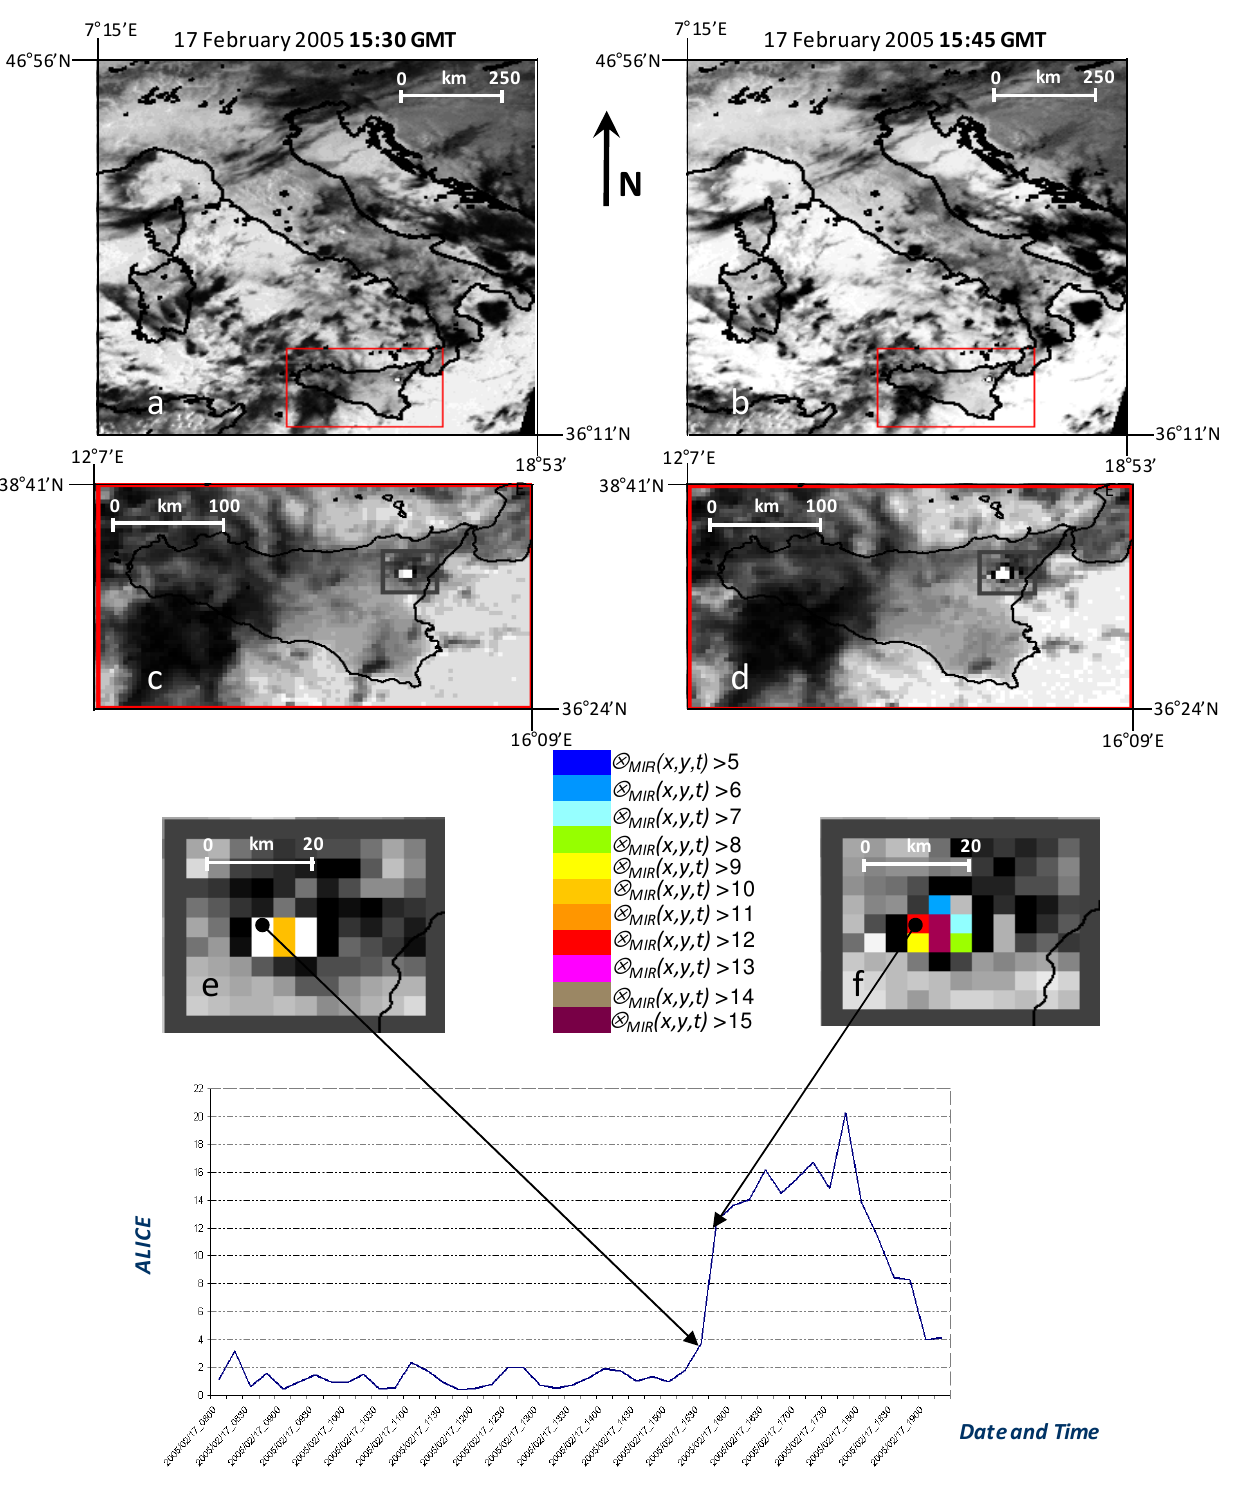
Figure 2. 15-minute temporal variation of the ⊗ eruptive vent that emitted a lava flow on 17 February 2005. On the top, two magnifications of the SEVIRI products of 15:30 (left) and 15:45 (right) are reported. On the bottom, the zooms of the volcanic area, and plot of temporal fluctuations of ⊗ arrows indicating pixel for which time series was